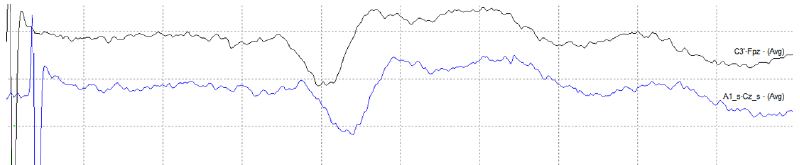
Figure 16. SSEP of a healthy volunteer. Grey curve originally obtained from the system. Blue curve, obtained from the proposed system. Voltage scale is 1µV/div., time scale is 5ms/div.